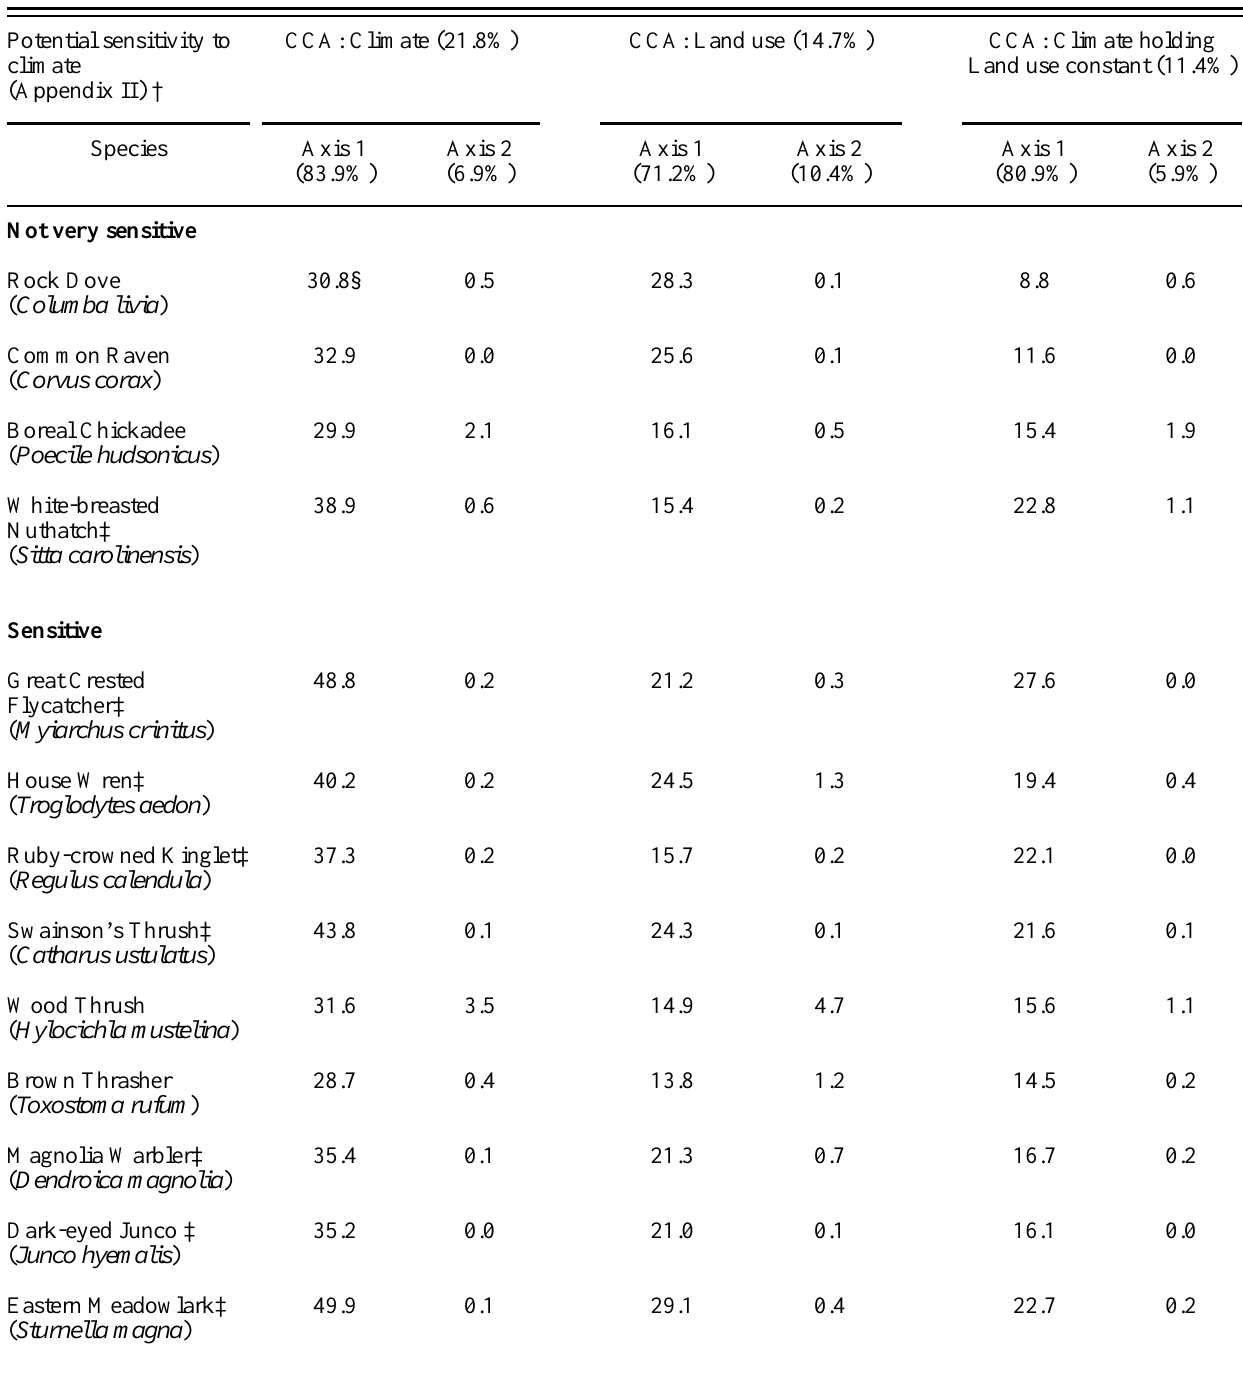
Table 5. Percentage of variance in the distribution of breeding bird species explained by climatic and land use variables, based on results for Axes 1 and 2 of three Canonical Correspondence Analyses